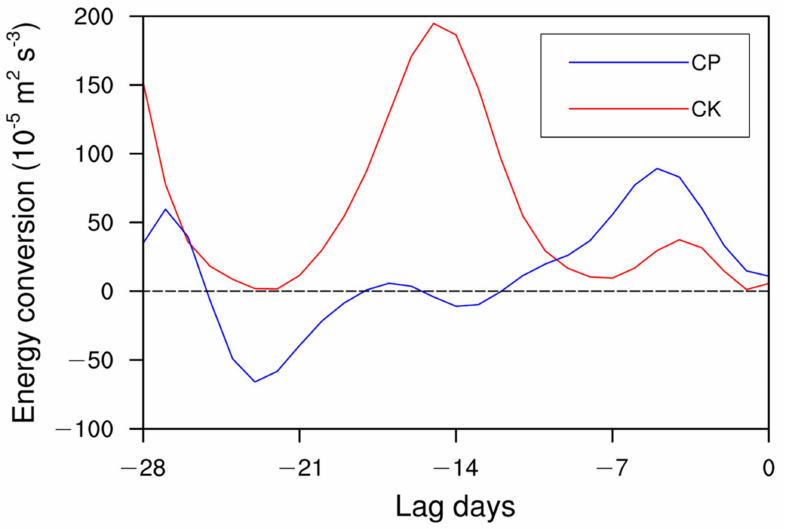
Figure 12. The evolution of barotropic kinetic energy conversion (CK, red line) and baroclinic available potential energy conversion (CP, black line) from lag − 28 to lag 0. The black dashed line represents the zero-contour